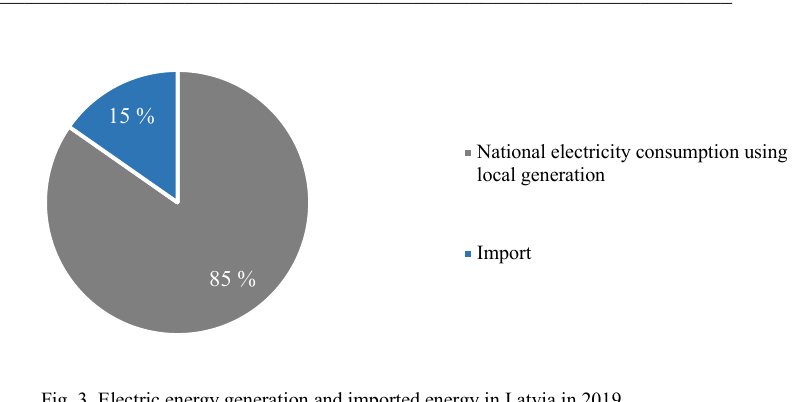
Fig. 3. Electric energy generation and imported energy in Latvia in